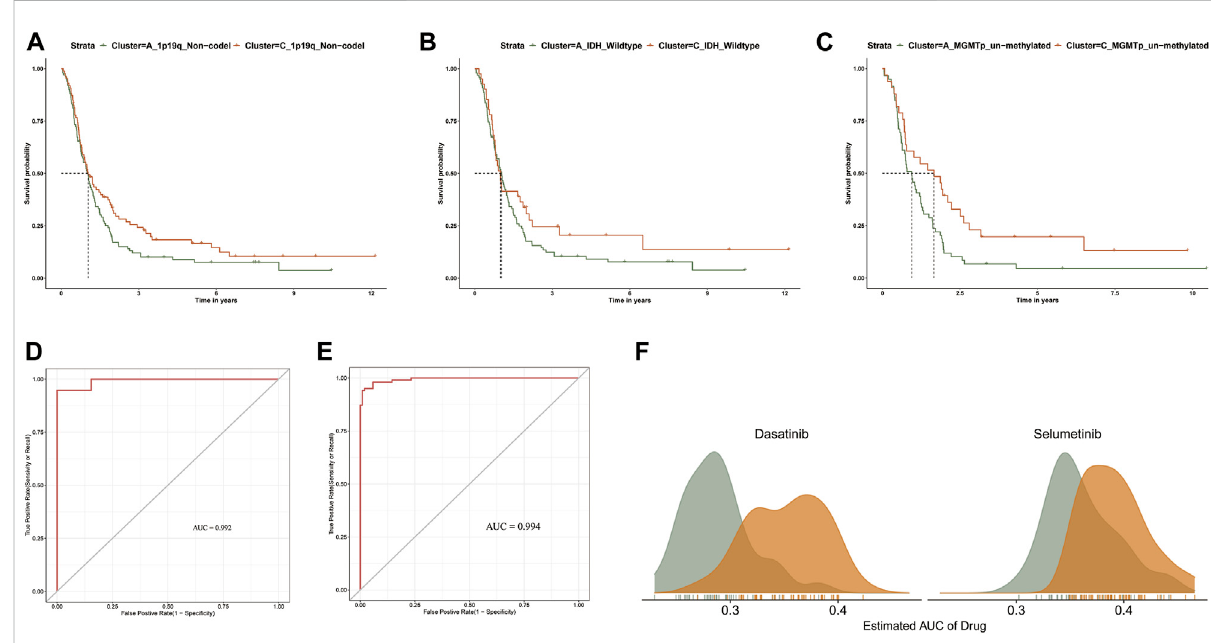
FIGURE 5 (A – C) Kaplan-Meier survival curve analysis between clusters A and C in 1p/19q_Non-codel, MGMTp_un-methylated, and IDH_wildtype). (D) The ROC curves of TCGA sample prediction results. (E) The ROC curves of CGGA sample prediction results. (F) Comparison of estimated Dasatinib and Selumetinib